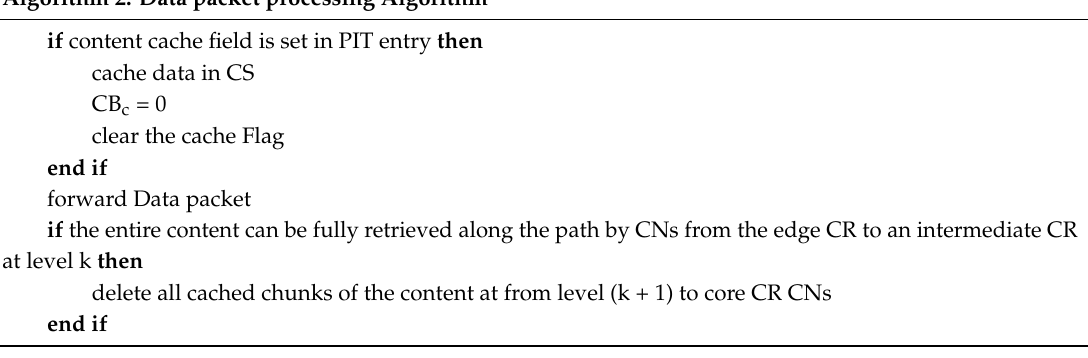
Algorithm 2. Data packet processing